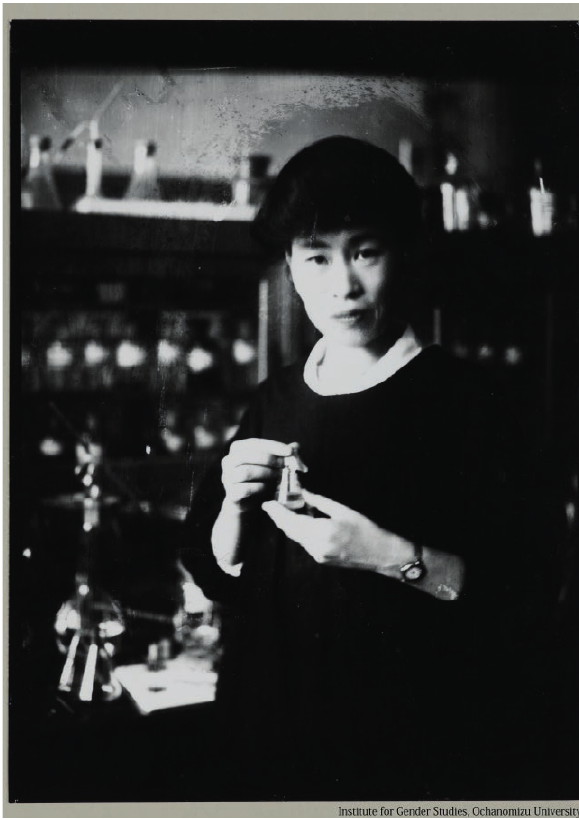
Figure 6. Kuroda Chika, (Ku-6107), at age 40, at RIKEN, the Physi- cal and Chemical Research Center, 1924. (Ochanomizu University History Museum. Reproduced with permission).